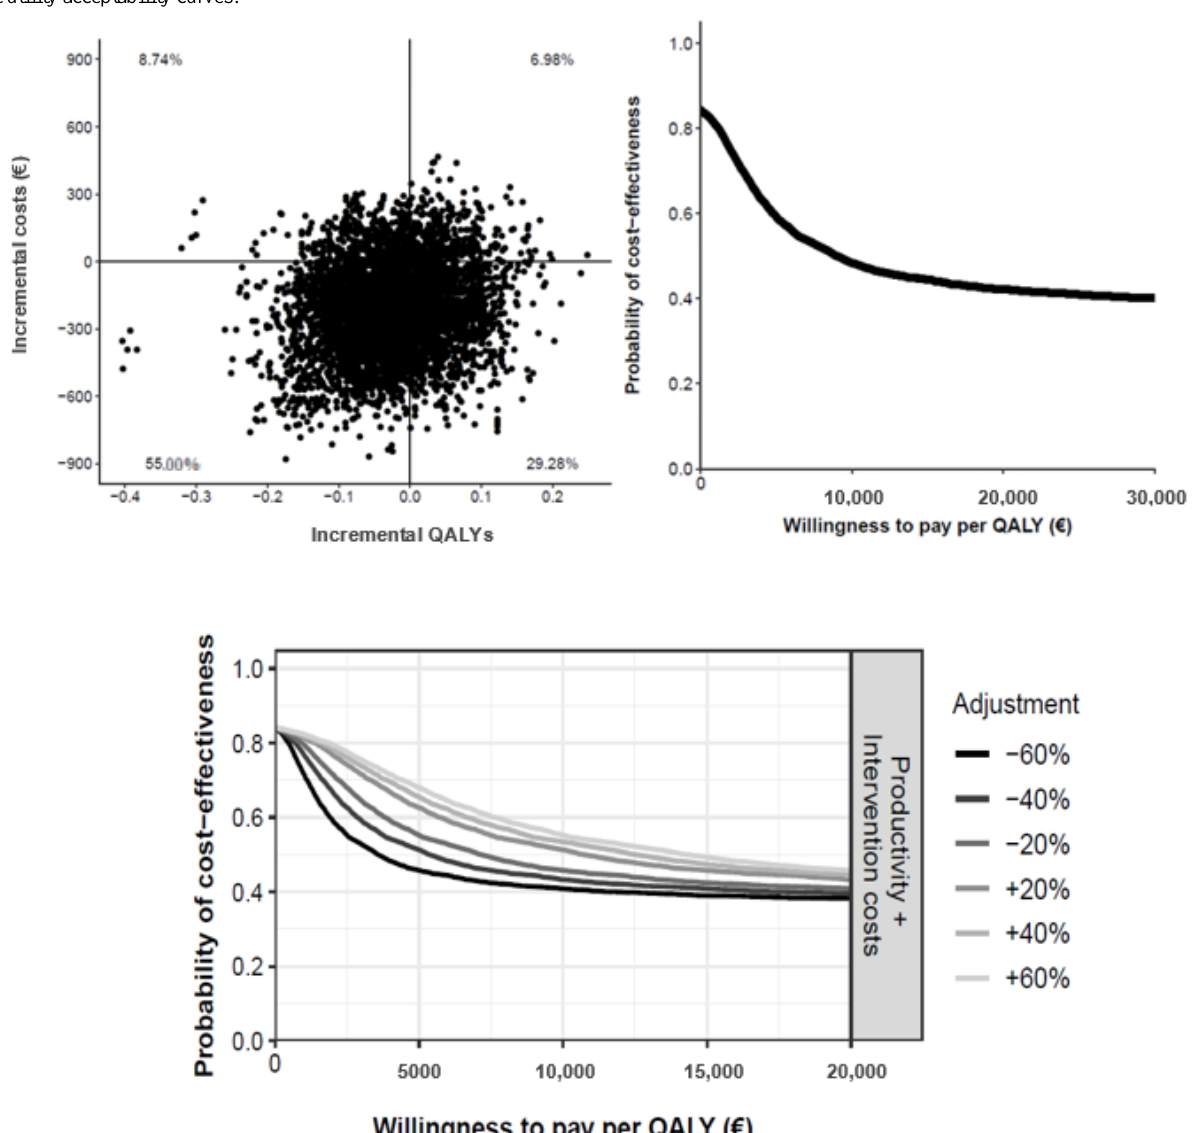
Figure 6. Cost-effectiveness plane (top left) and cost-effectiveness acceptability curve (top right) comparing the effect on quality-adjusted life-years (QALYs) of Telemonitoring of Crohn’s Disease and Ulcerative Colitis (TECCU) versus standard care. Bottom: impact of different cost values on the cost-utility acceptability